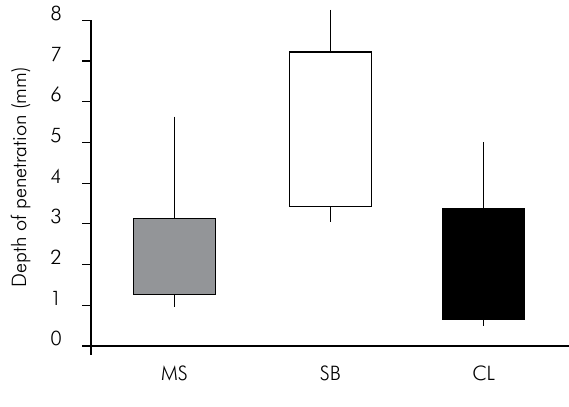
Figure 3. Impact of the obturation technique on filling material penetration (mm) into lateral canals of the apical third